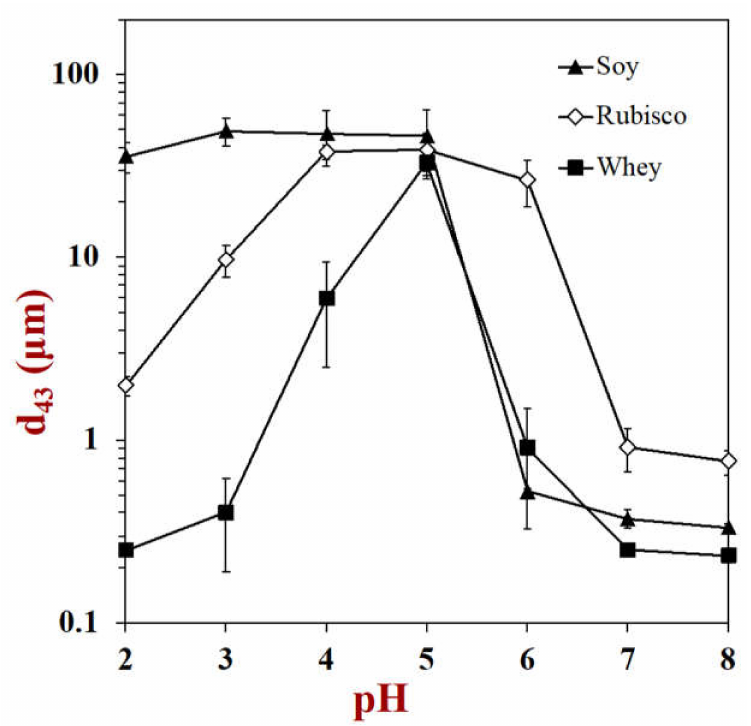
Figure 12. The pH stability of protein-coated oil droplets is highly dependent on protein type. This figure shows the change in mean particle diameter with pH for emulsions stabilized by soy, rubisco, and whey protein (data from our